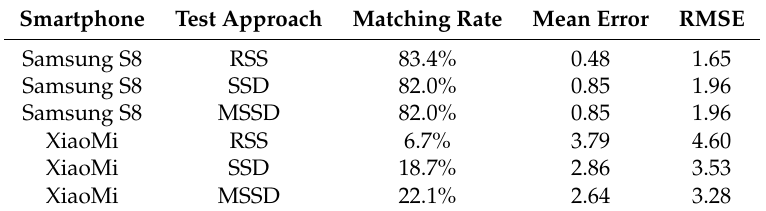
Table 1. Static test results for Samsung S8 and XiaoMi smartphones. It is noted that each phone collected 300 online measurements, and Samsung S8 collected the fingerprints. The unit of mean positioning error as well as RMSE is